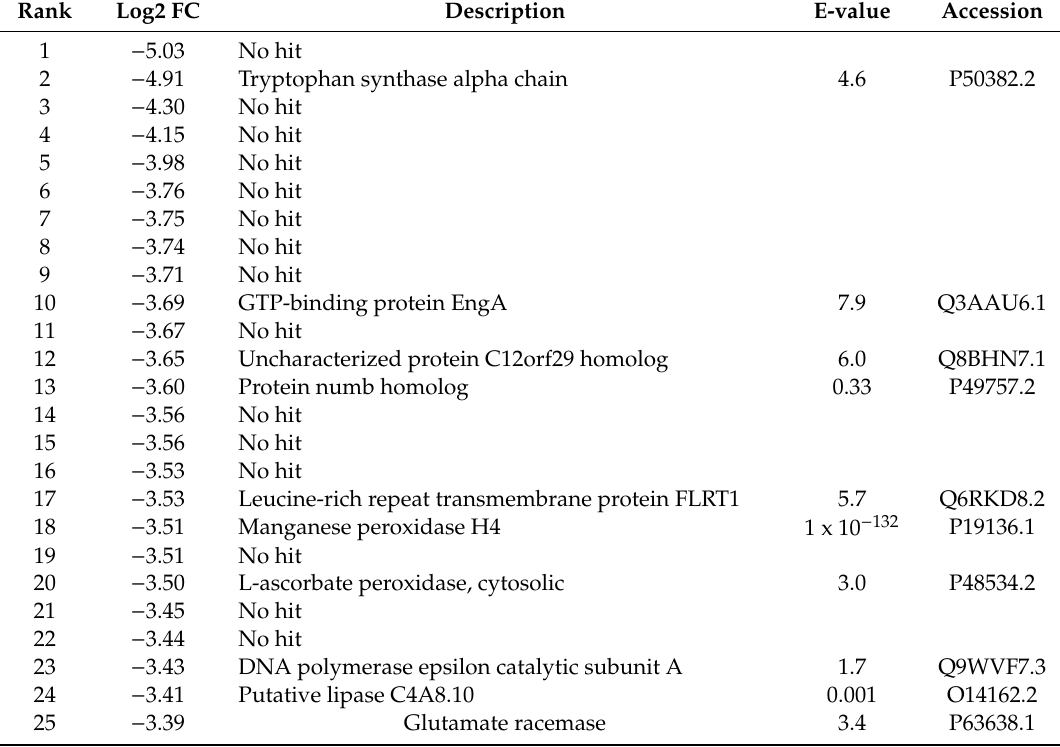
Table A5. Top 25 down-regulated transcripts of Inonotus obliquus library of cells cultivated in presence of white birch